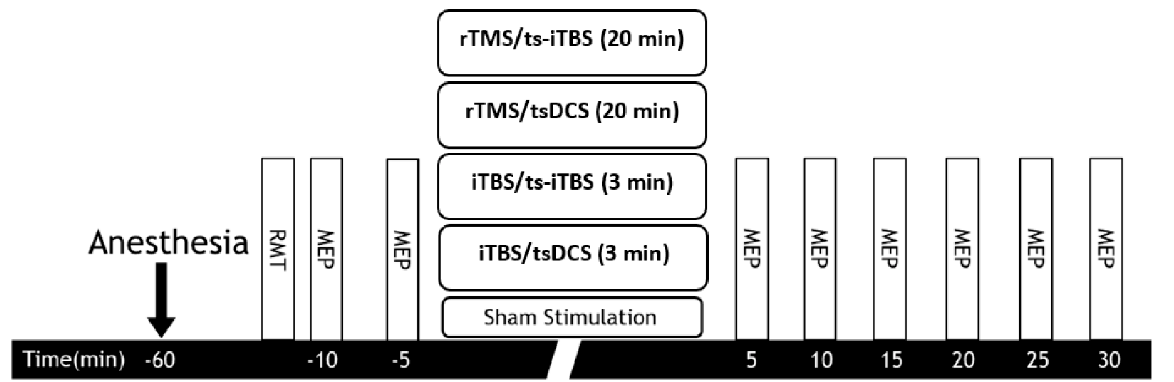
Figure 12. MEP assessment and stimulation interventions for T10 spinal cord injury.